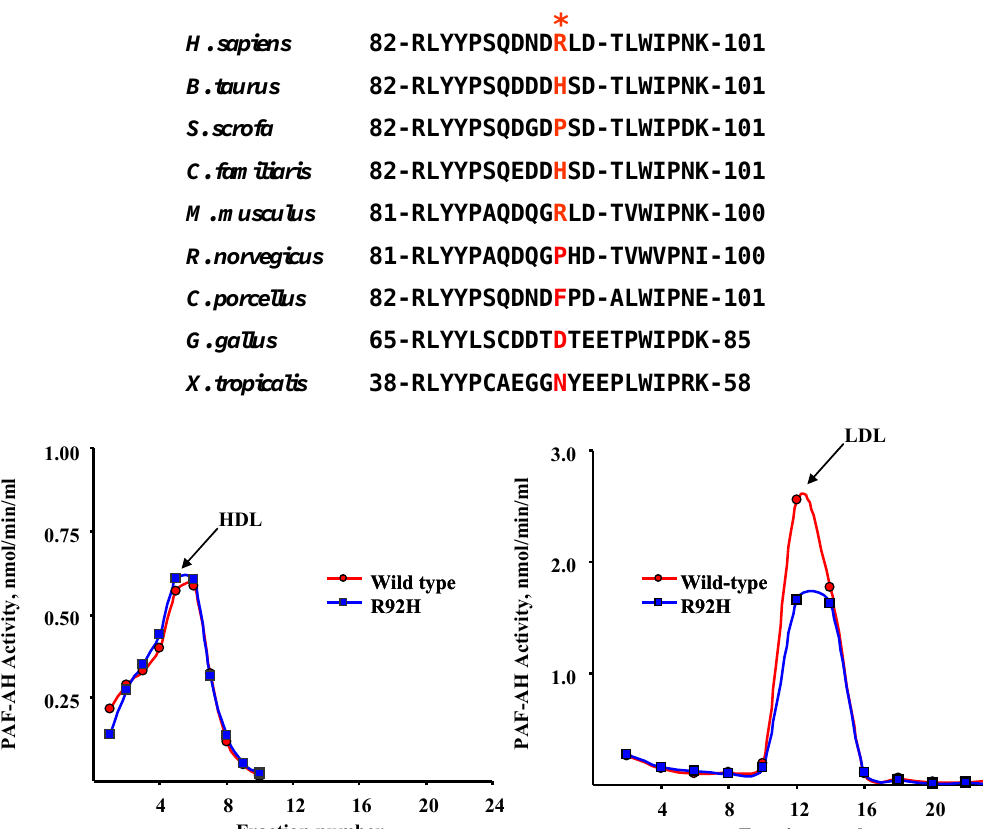
Figure 2. The R92H variant binds to human HDL and LDL in vitro.